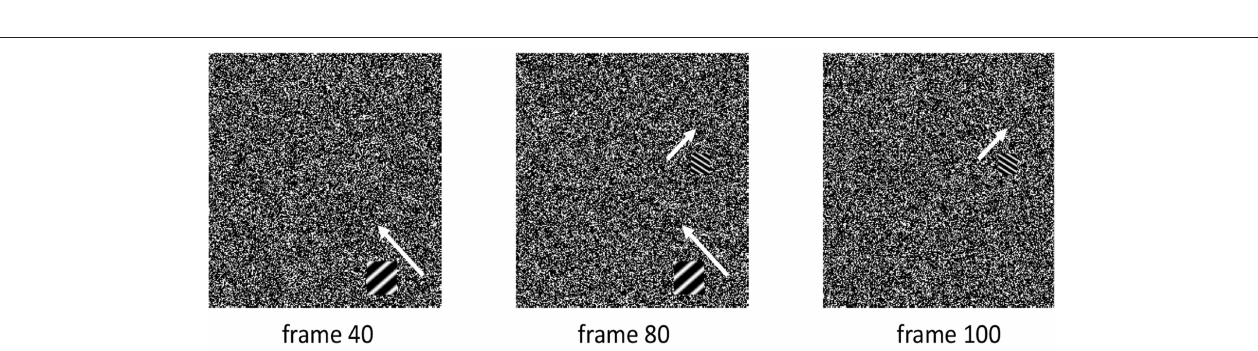
FIGURE 6 | Multi-variate RP for the case presented in Figure 2 . (Top-left) The multi-variate RP computed on all points and all samples ( X (Top-right) Multi-variate RP is generated using only the relevant points in the geometric structure (set S ). (Bottom-left) Multi-variate RP using only the points within the region of recurrence (set S ), and the time interval corresponding to the temporal extension of the recurrent pattern ( T (Bottom-right) Multi-variate RP computed on the region of interest and time interval (frame 35 through 65) reported in Figure 5 .